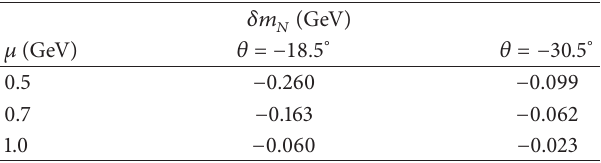
Table 2: Self-energy of a nucleon, 𝛿𝑚 𝑁 , in GeV unit, as a function of regulator scale Λ for the same form factors as in Table 1, but for 𝜃 = −30.5 ∘ . 𝛿𝑚 𝑁 (GeV) Λ (GeV) Dipole Exponential Monopole 𝑢 𝑢 3/2 𝑢 2 𝑢 𝑢 3/2 𝑢 2 0.6 − 0.012 − 0.044 0.8 − 0.044 − 0.014 − 0.115 − 0.073 − 0.052 − 0.051